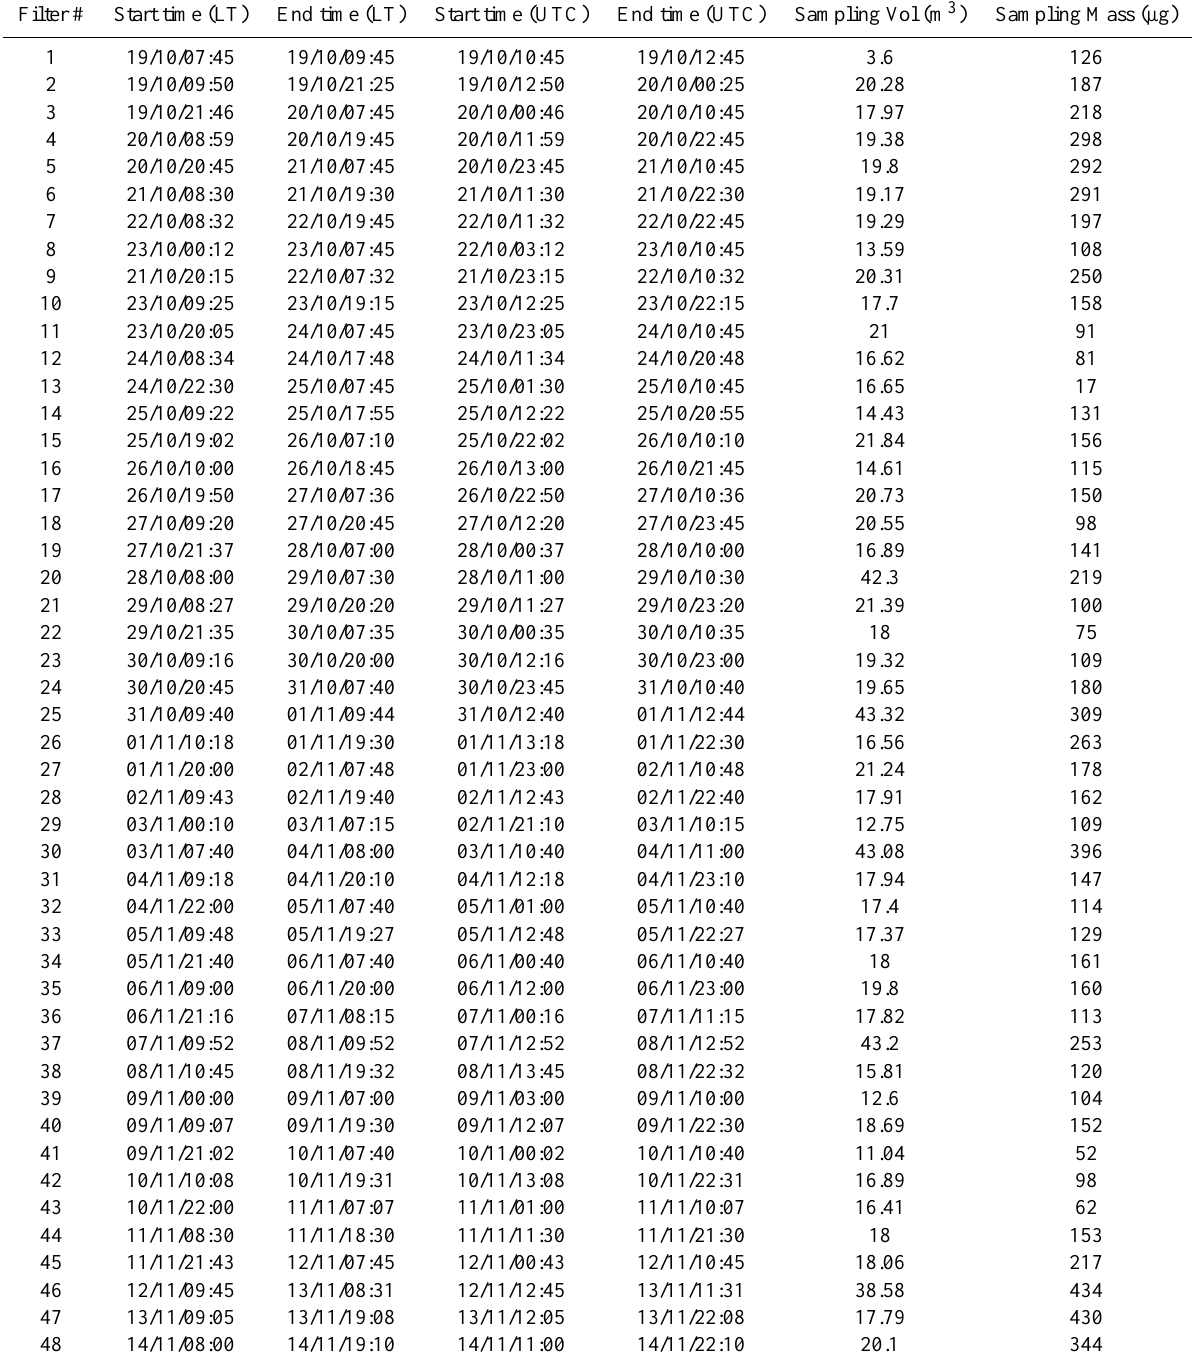
Table 1. Filter sampling start time, end time, volume sampled and the aerosol loading